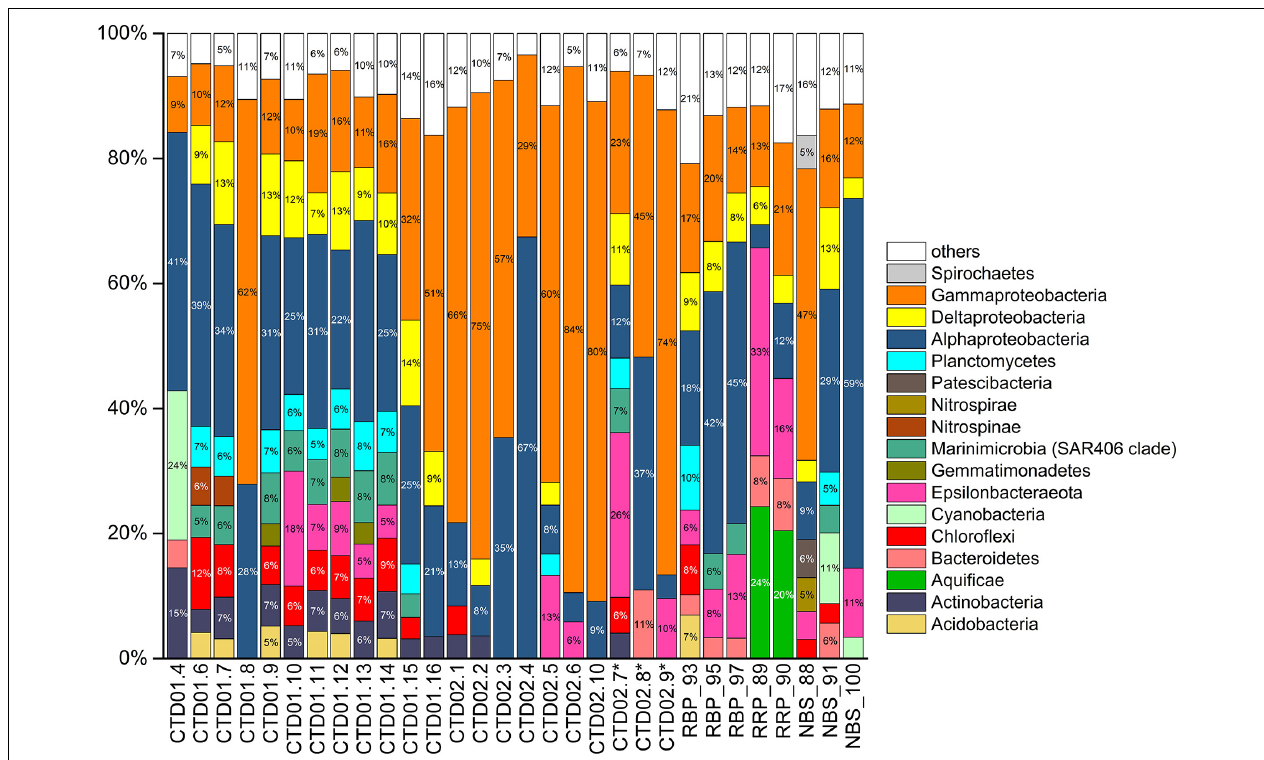
FIGURE 4 | Histogram of bacterial communities from all samples at phylum and class levels (for Proteobacteria ). Only bacterial lineages with abundances > 3% percentages are listed. The rest are classified into “others” group. ∗ Indicates the three non-buoyant plume samples identified based on CH 4